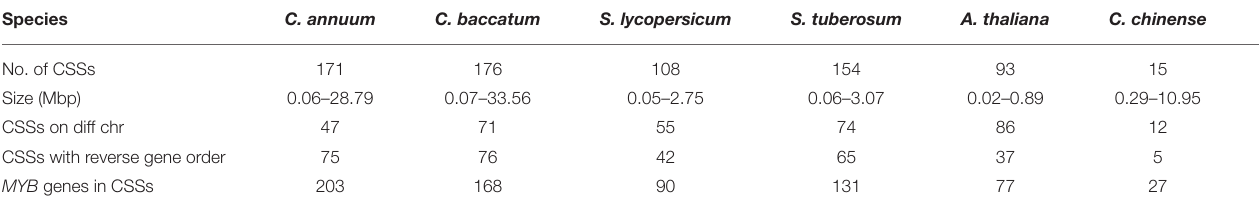
TABLE 2 | Number of conserved syntenic segments (CSSs), with at least one MYB gene in them, their size in million base pairs (Mbp), and their diversification in different Solanaceae genomes and Arabidopsis thaliana .